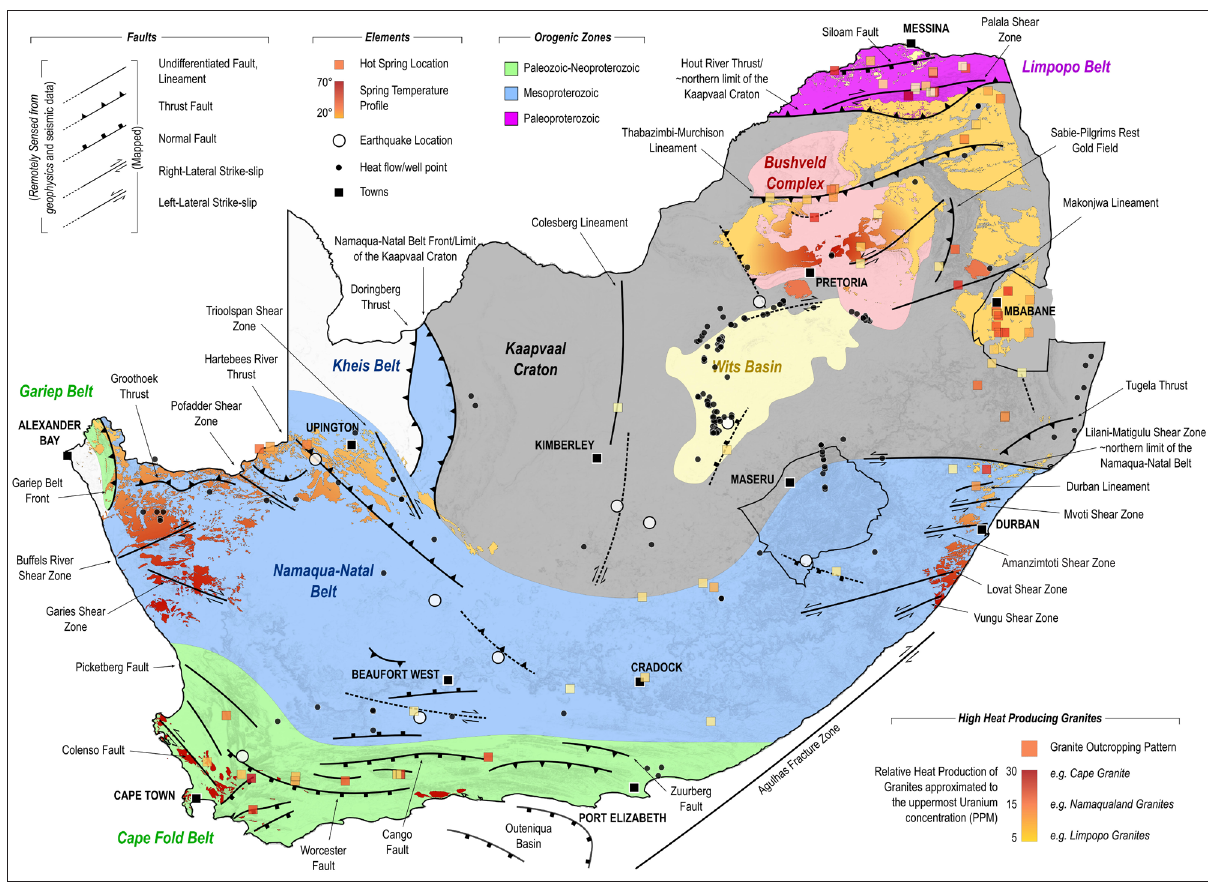
Figure 2: Overview of the major tectonic structures and zones across South Africa with the locations of significant earthquake focal mechanisms and inferred structures related to these events. Locations of the various data sources used within this study (e.g. hot springs and temperature measurement points) and high heat producing plutonic rocks are also highlighted. Note that the Namaqua-Natal Belt probably continues beneath the Cape Fold Belt as far as the offshore Agulhas Fracture Zone.